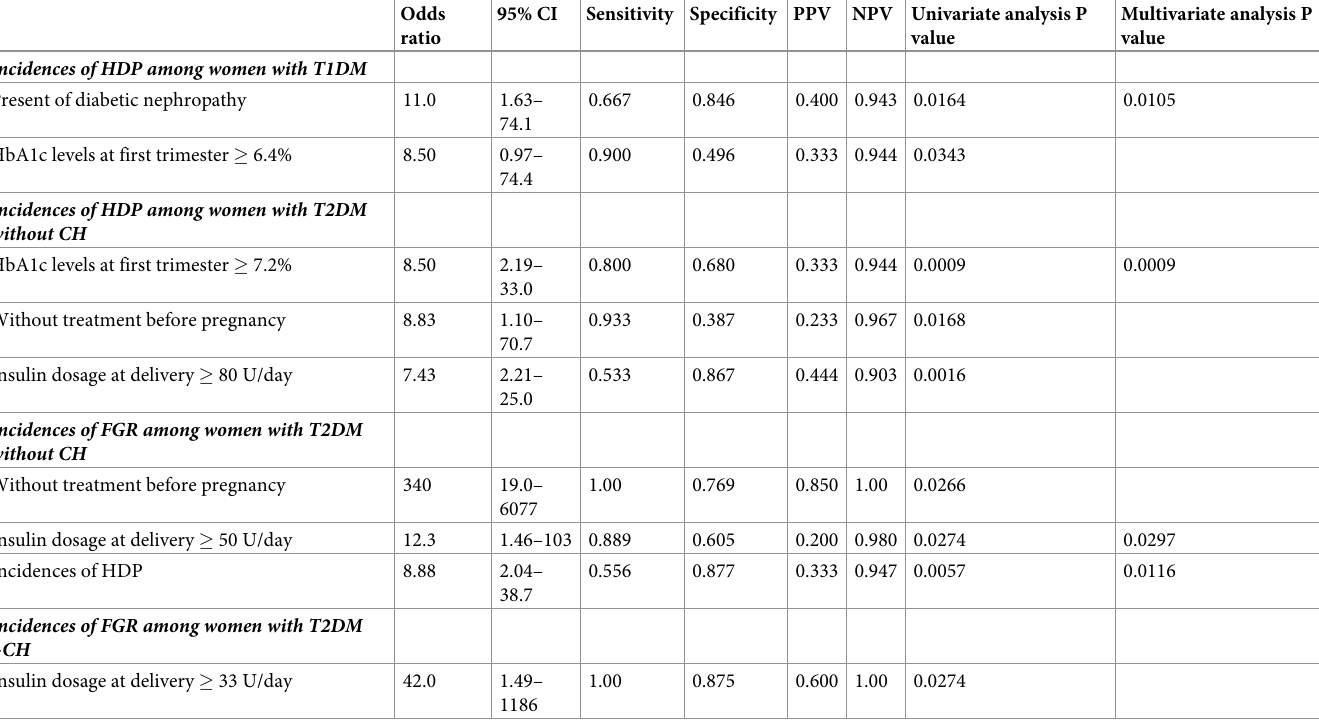
Table 2. The predictors of the incidences of HDP and/or FGR among women with T1DM or T2DM without CH.